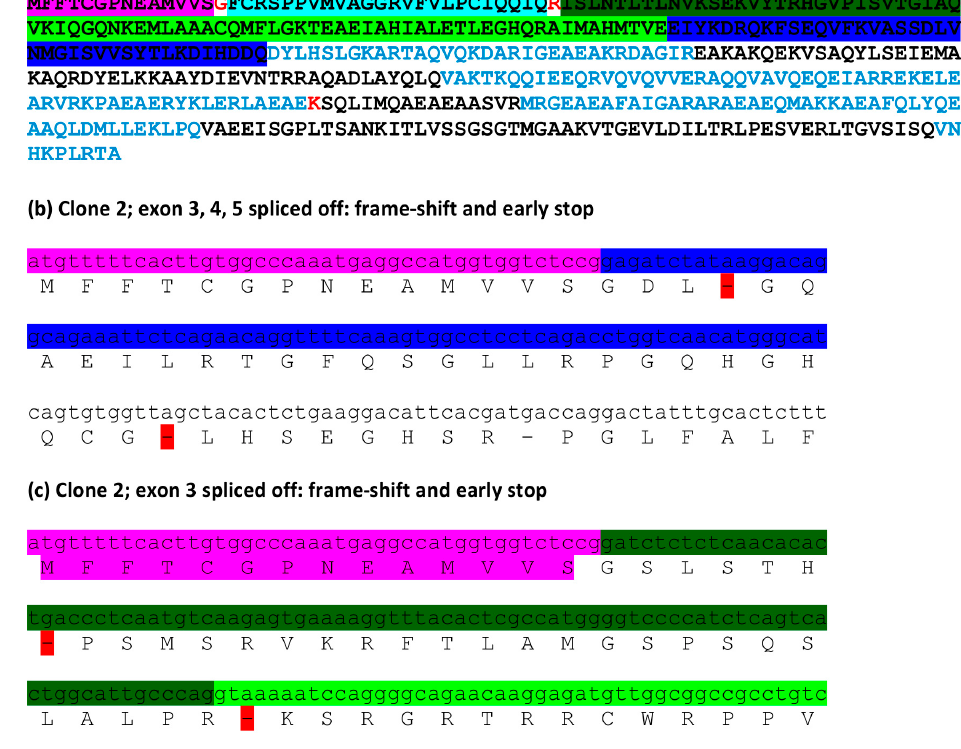
Figure 6. Predicted consequences of the changes in FLOT1 mRNA sequences at the protein level: frame shift and early stop of translation. ExPasy Translate tool was used to convert the sequencing data to protein sequences. ( a ) WT flotillin-1 protein sequence with the same exon color coding as in Figure 5. The codons for the residues marked in red are compiled from the flanking exons; ( b ) clone 2: removal of exons 3–5 results in a frame shift and early stop; as does ( c ) the removal of exon 3.